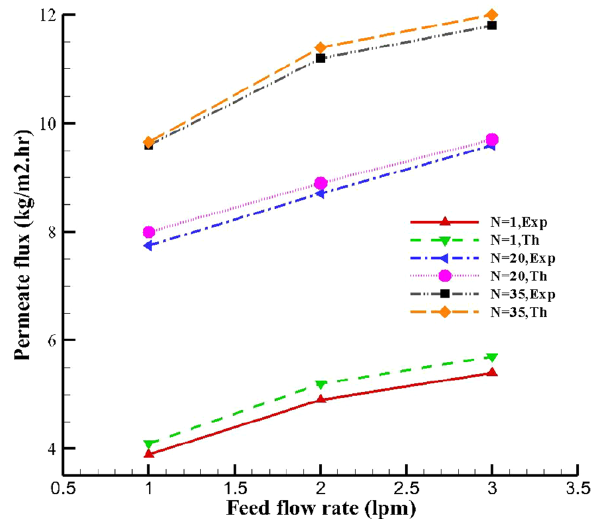
*Base line values of